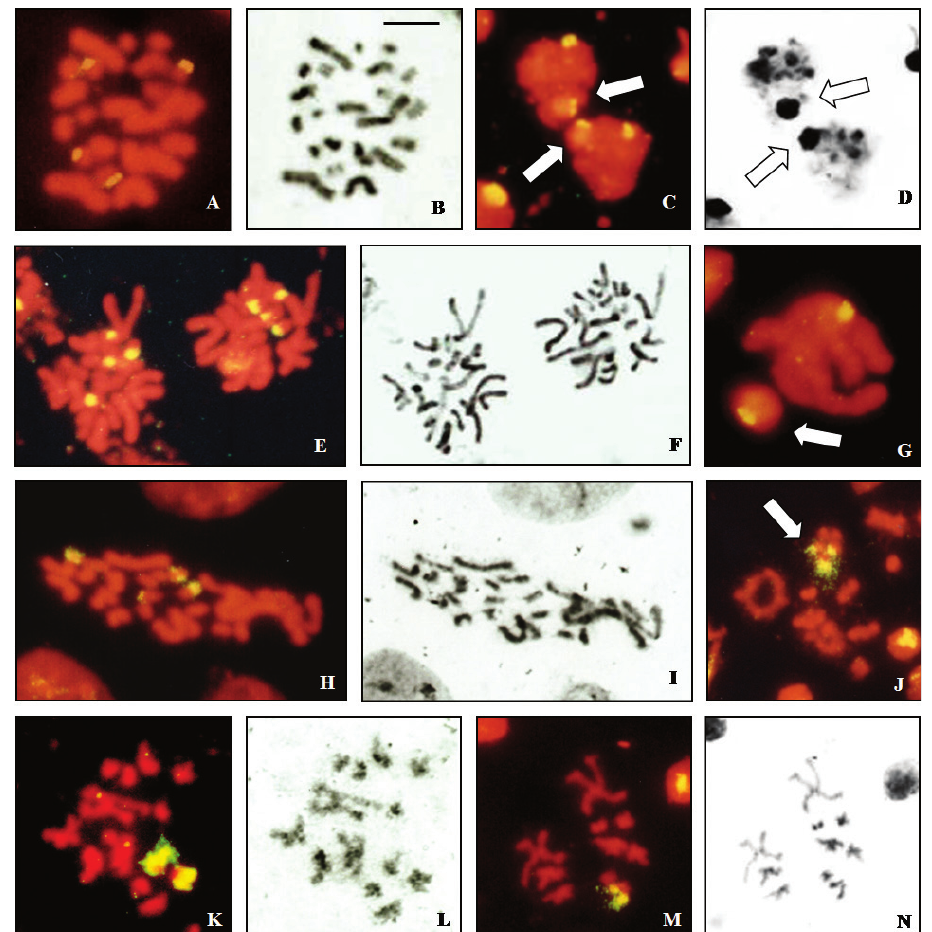
Figure 3a–n. Localization of rDNA clusters in Cicindela , revealed by in situ hybridization of the PCR amplified ribosomal probe to squashed mitotic and meiotic chromosomes. The phase contrast image of some cells is figured to the right of the fluorescence image. a, b C. deserticoloides , male mitotic metaphase c, d C. deserticoloides , zygotene nuclei; n=9+X circumdata , zygotene nuclei; n=9+X metaphase I plate, n=9+X trisignata , male metaphase II plate (n=9+Y). Arrows indicate the sex chromatin. Bar = 5